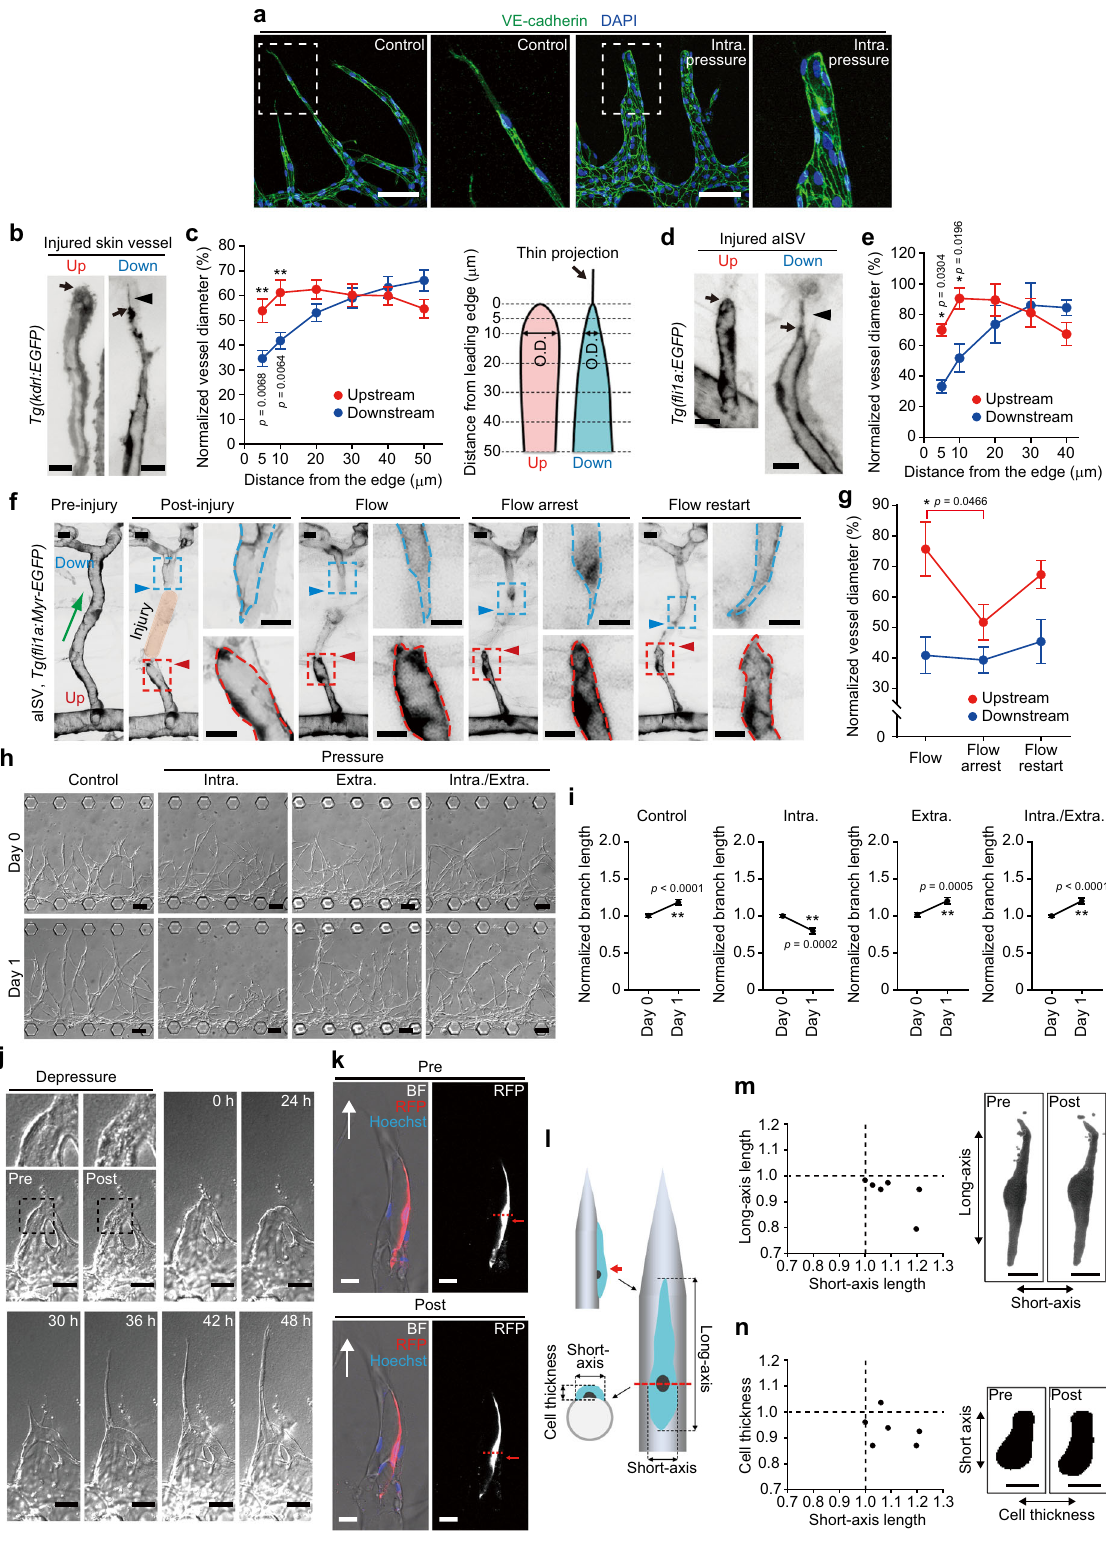
Fig. 7b – e and Supplementary Movies 13 and 14). Furthermore, the shrunken vessels loaded with EP were only slightly expanded by additional loading of IP (Supplementary Fig. 7d, e and Supplementary Movie 15), suggesting that ECs in vessels loaded with either EP or both EP and IP were not exposed to stretching, despite hydrostatic pressure application. Thus, using our